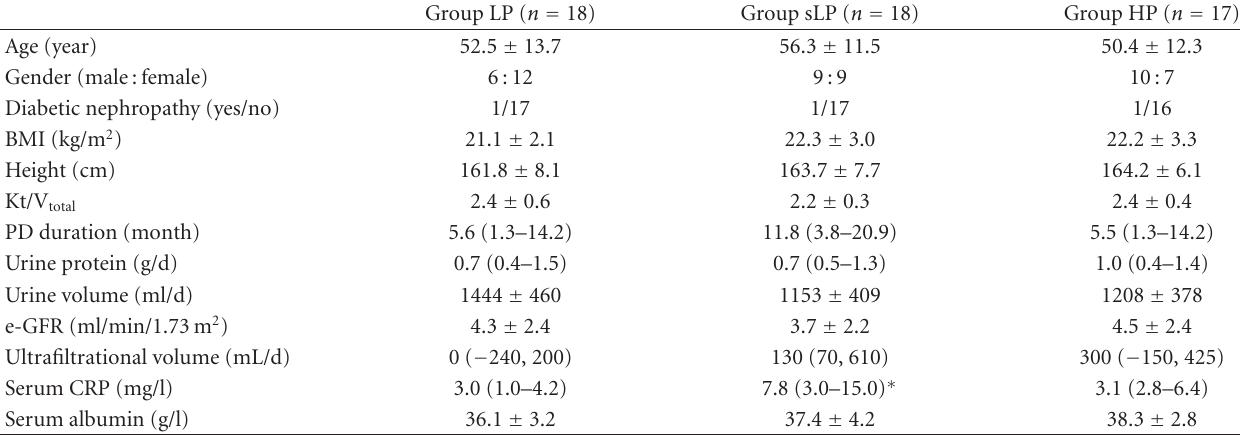
Table 1: Baseline data of the 53 PD patients, grouped according to the diet that they asre randomized to.